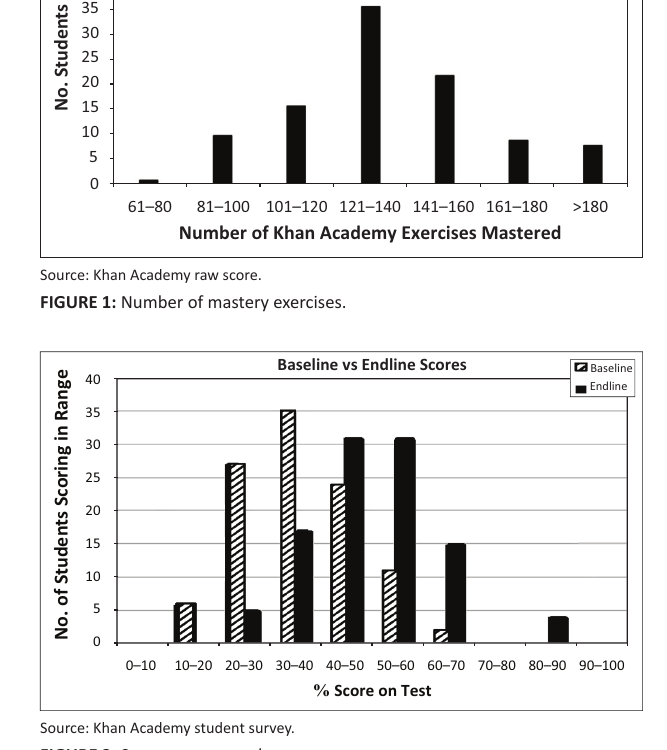
FIGURE 2: Scores on pre- and